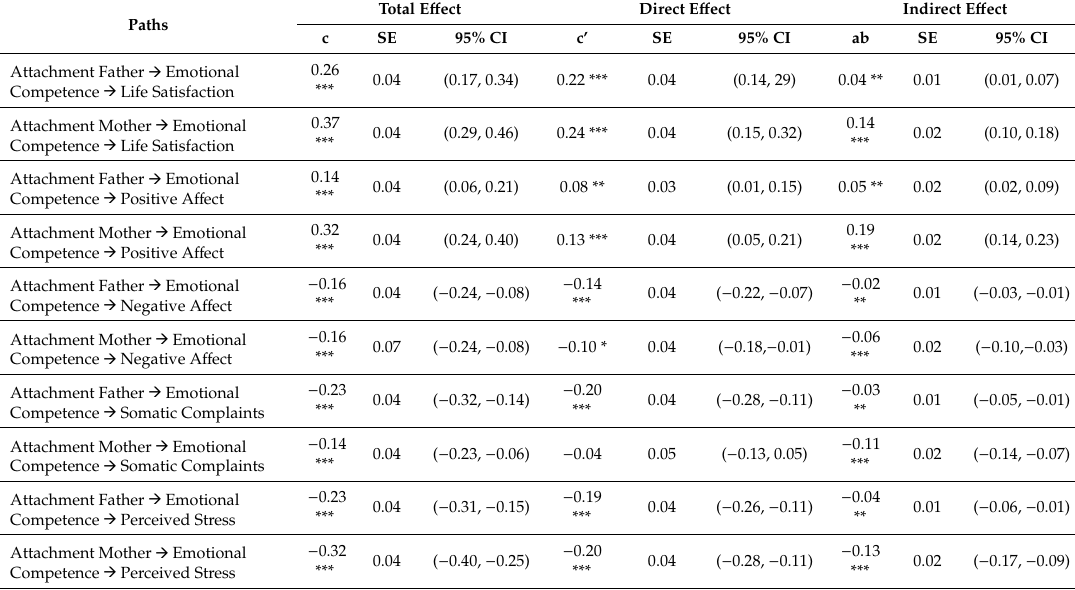
Table 4. Fit Indices for Multigroup SEM and χ ²-Difference Test Results.